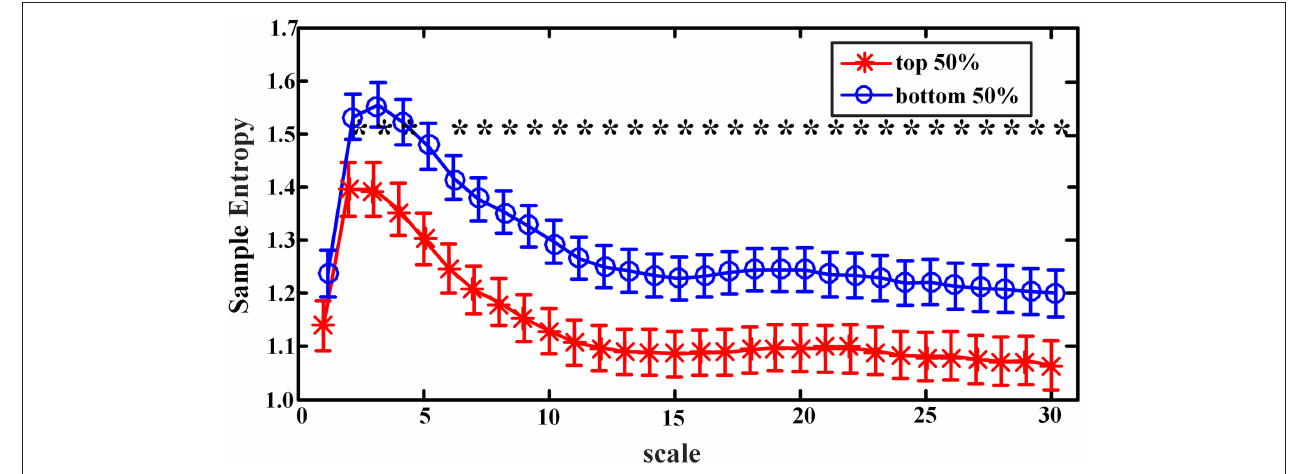
FIGURE 3 | Complexity indices (sample entropy, mean ± SD) on scale 1–30 in groups classified by the rank of EEMD-SWA 90 (top 50% vs. bottom 50%). The symbol ‘*’ indicates significant difference between groups ( p < 0.05, covariance analysis, controlling the age, gender, and BMI). After the procedure of FDR, the significant differences all